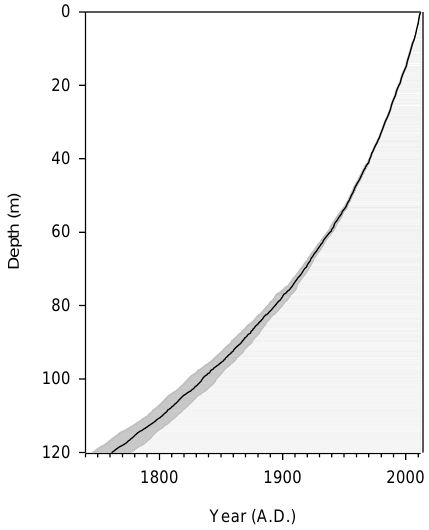
Figure 4. Age–depth relationship for IC12 reconstructed from the relative dating process. Grey shading shows the uncertainty range between the oldest and the youngest estimates. The uncertainty range reaches a maximum of ± 16years at the base of the